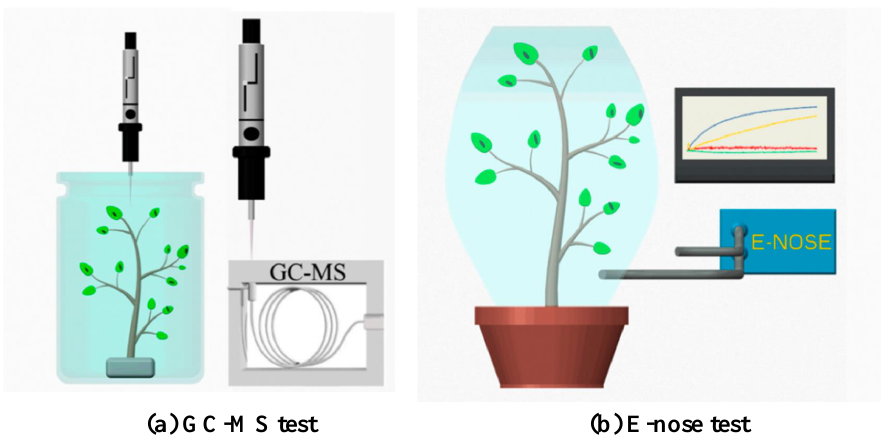
Figure 10. Schematic of an E-nose and a GC-MS-based system for VOC detection in plants